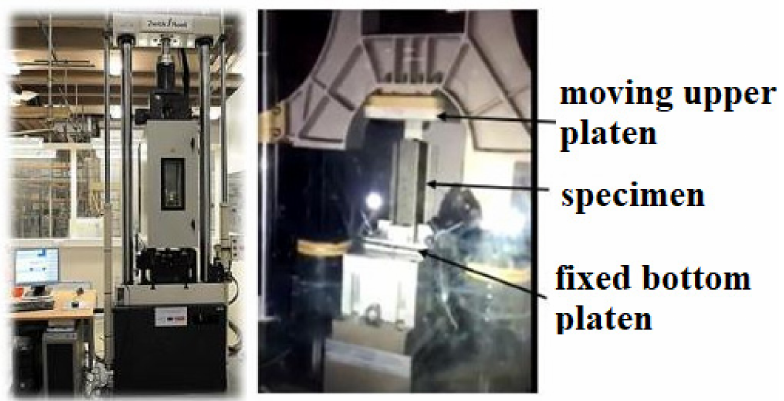
Figure 5. Zwick ± 250 kN Fatigue ( left ) and Instron Drop Tower ( right